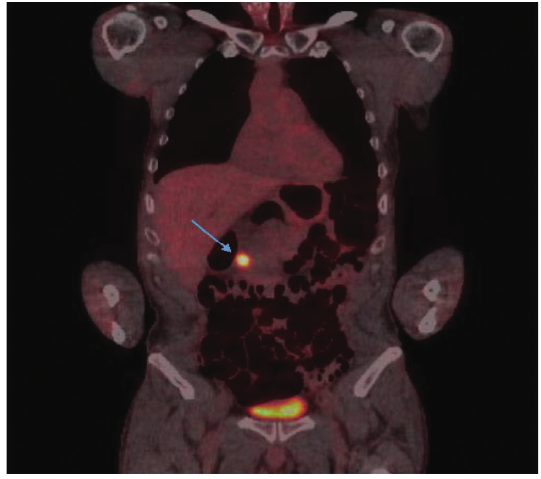
Figure 4: Positron emission tomography-computed tomography scan showing a focus of intense activity corresponding to the area of the pancreatic head (blue arrow) without a clear anatomical correlate.